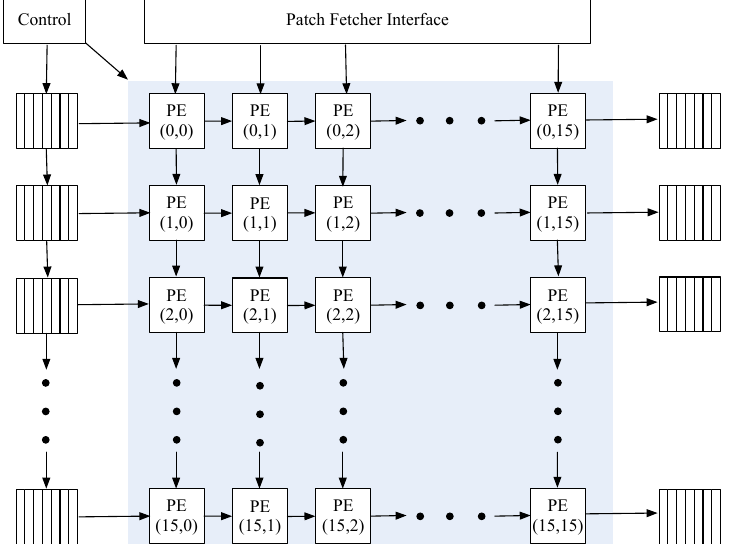
Figure 2. The structure of SAFA. SAFA is a 16 × 16 systolic array containing 256 identical and simple PEs. The key of SAFA is expressed as (1) local interconnecting and (2) shifting data